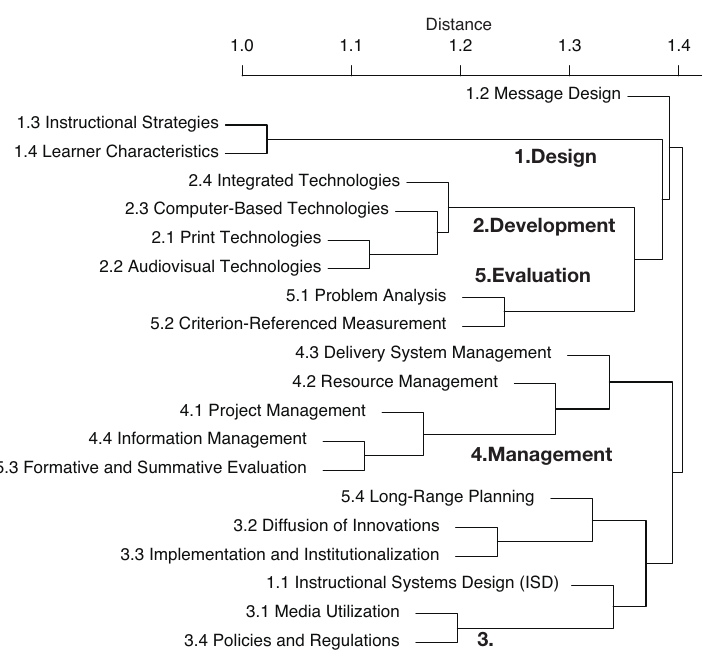
Figure 2. A dendrogram for subdomains of AECT curriculum